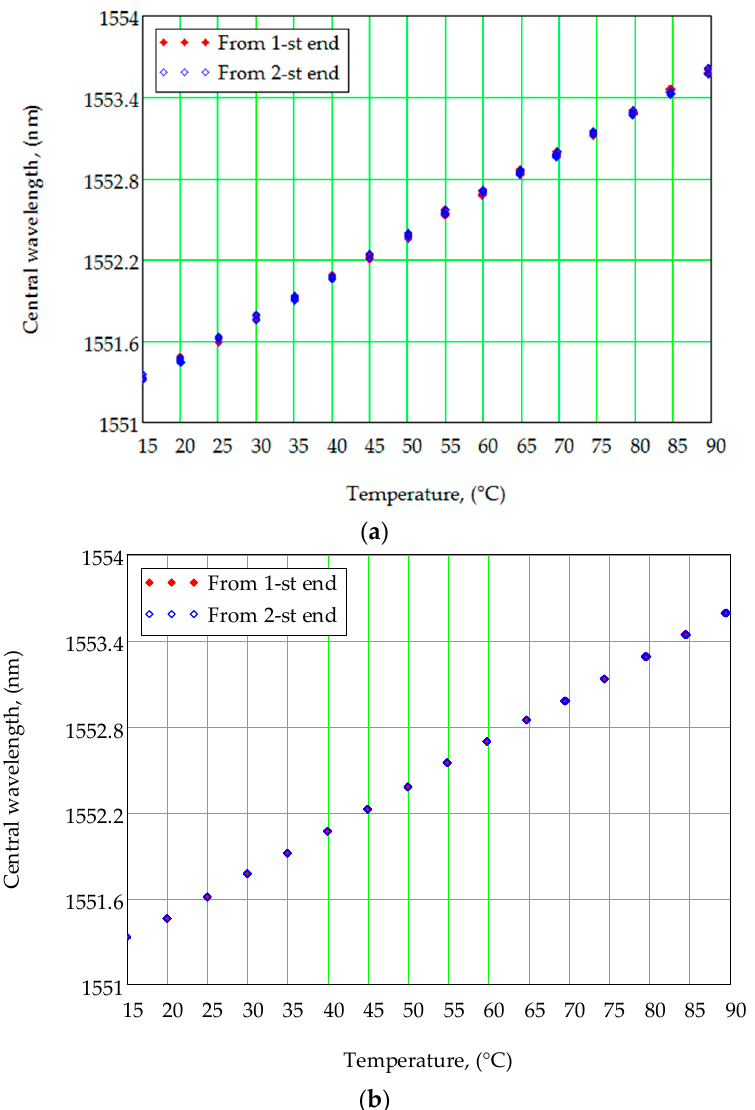
Figure 6. Calibration curves–FBG central wavelength dependences on temperature. The measured data: ( a ) without spectrum correction; ( b ) with spectrum